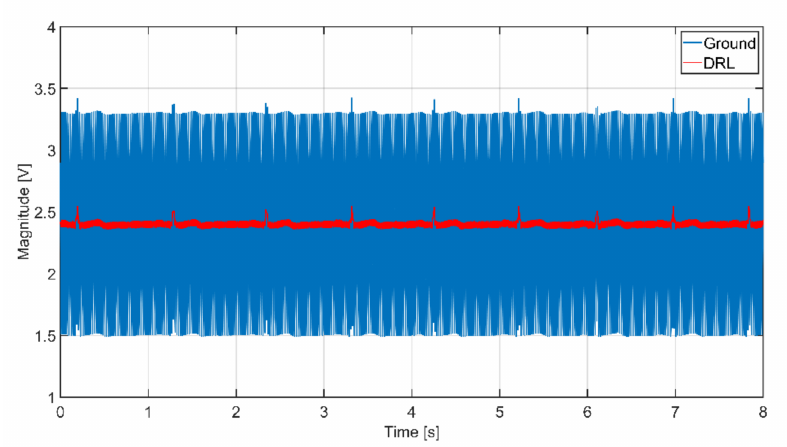
Figure 16. The output signals from simulation while using different coupling capacitances ( C e1 = 150 pF, C e2 = 75 pF) at the input in two scenarios: The NSE connected to the ground (solid blue), and NSE connected to the output of DRL (solid red).